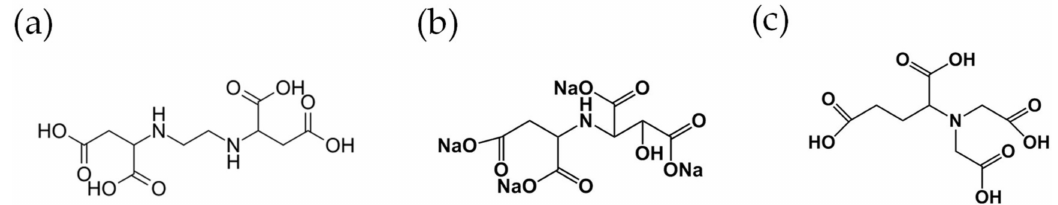
Figure 1. The structure of each chelating agent: ( a ) EDDS; ( b ) HIDS; ( c ) GLDA. Table 3. Conditions of the pot experiments using different kinds of chelating agents. Pot